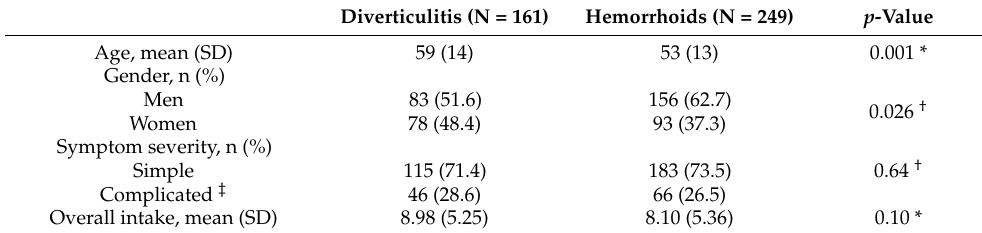
Table 2. Demographic, clinical, and dietary characteristics of